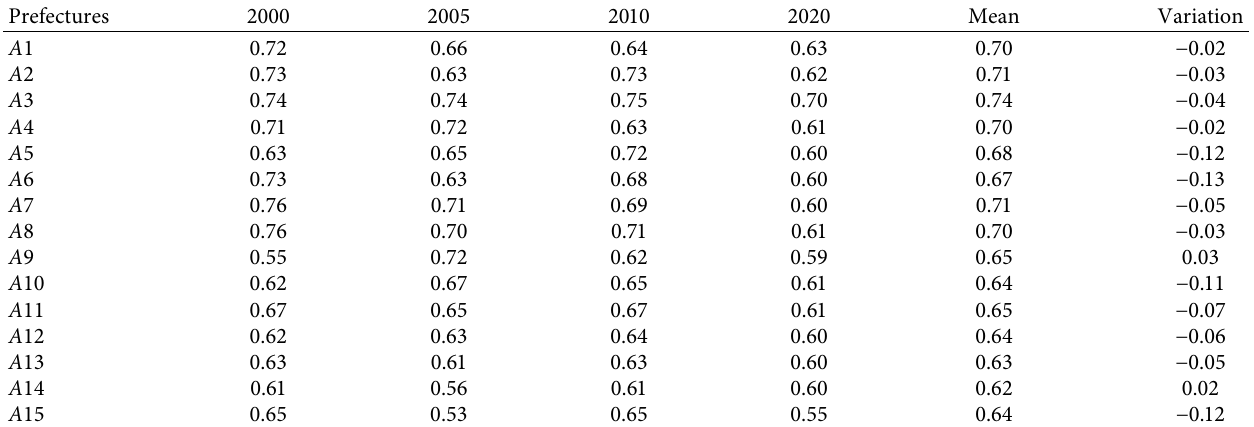
Table 1: Gini coefficients of spatiotemporal development of regional higher education.